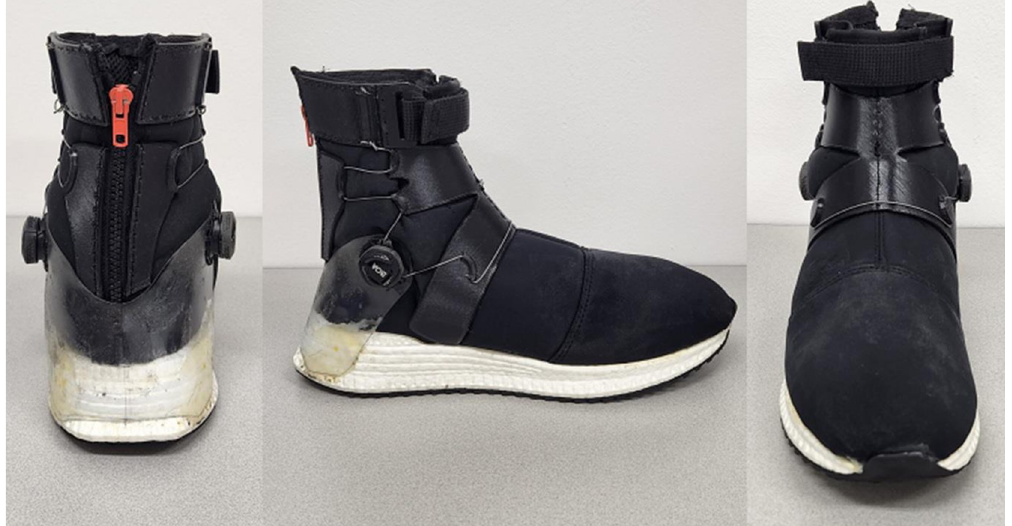
Fig 1. The prototype high-collar shoe was designed for this study. A wire connects two ratcheting reels to uniformly spread the pressure around the ankle. This design allows precise control over CAP by adjusting the ratcheting reels and top strap.